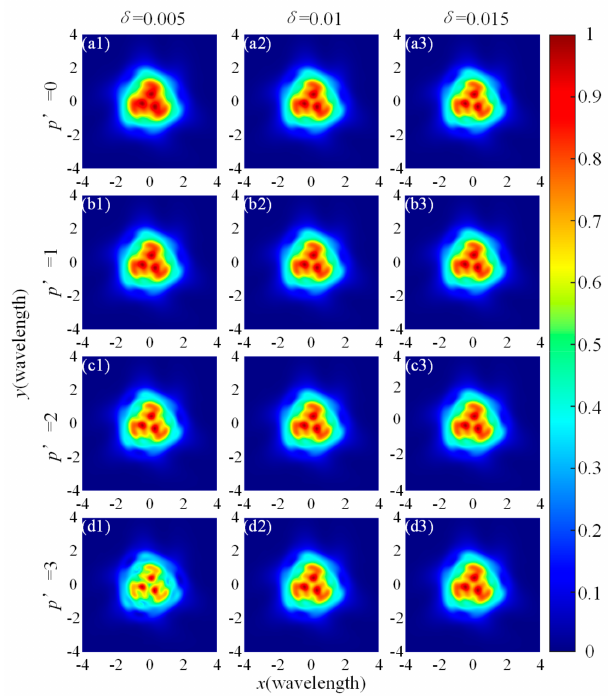
Figure 4. The normalized intensity distribution of different power exponents n and the order of LGSM p ’ ( l = 3, δ = 0.005 m, and p = 1). When the order of LGSM p ’ is 0 to 3, the total intensity distribution of ( a1 – d1 ) the power exponents n = 1, ( a2 – d2 ) the power exponents n = 2, and ( a3 – d3 ) the power exponents n = 3.